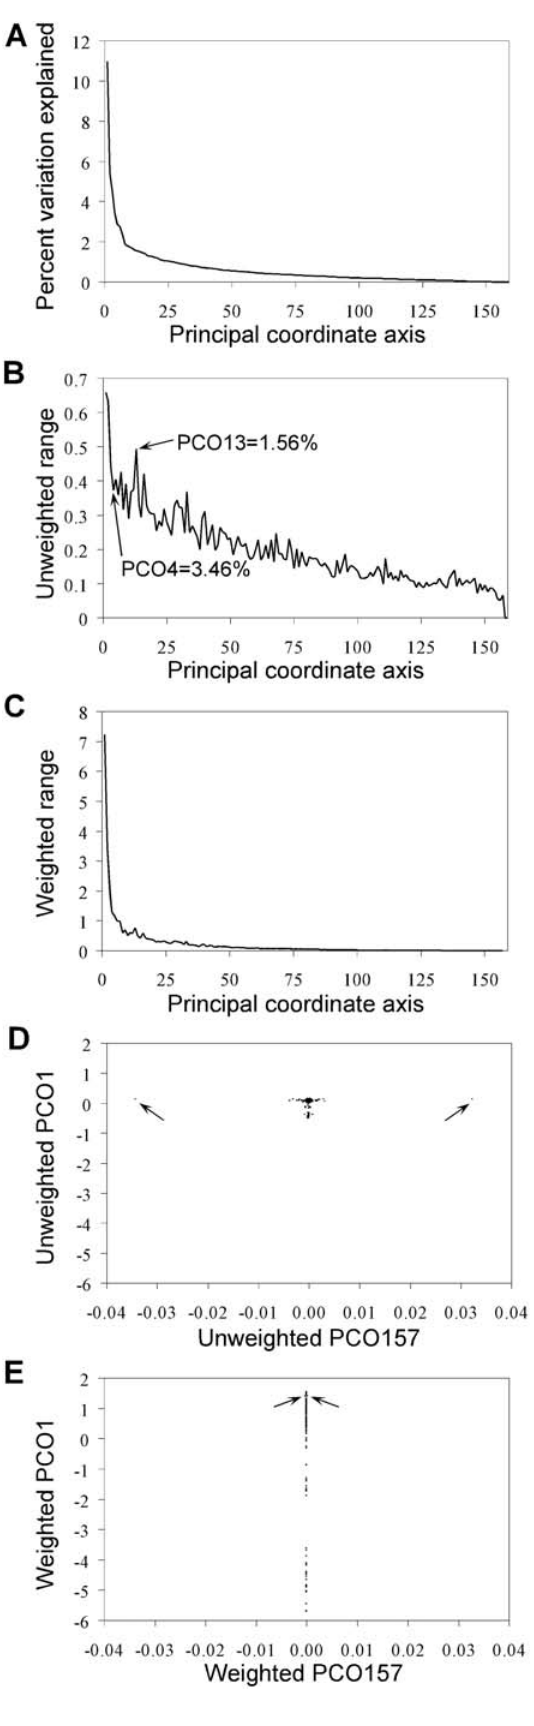
Figure 1. Weighting scheme to improve density estimation. A) Percent of total variation explained by each principal coordinate axis for an exemplar data set from Humulus lupulus . B) Before weighting, high order axes may contribute disproportionally to the dispersion of points along an axis. One problematic pair of axes (PCO4 and PCO13) is indicated. C) After weighting, the maximum distance between points better reflects the importance of the axis. D) Before weighting, two outliers present along PCO157 could detrimentally affect the analysis because density estimation only considers dispersion between points, not axis importance. E) After weighting, the spatial information present in inconsequential axes exerts little influence. Arrows mark the position of the two